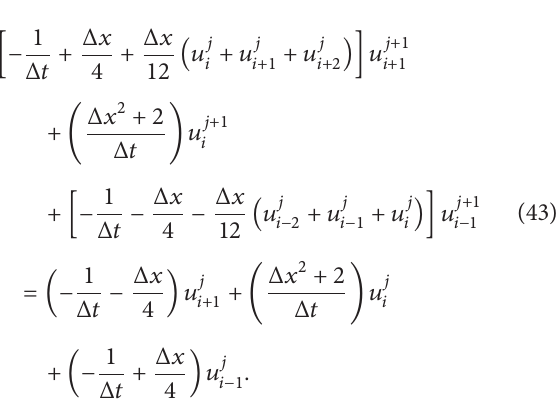
The unknown values of 𝑢 in 𝑎 1 and 𝑐 𝑛−1 are determined from Neumann boundary conditions obtained from the